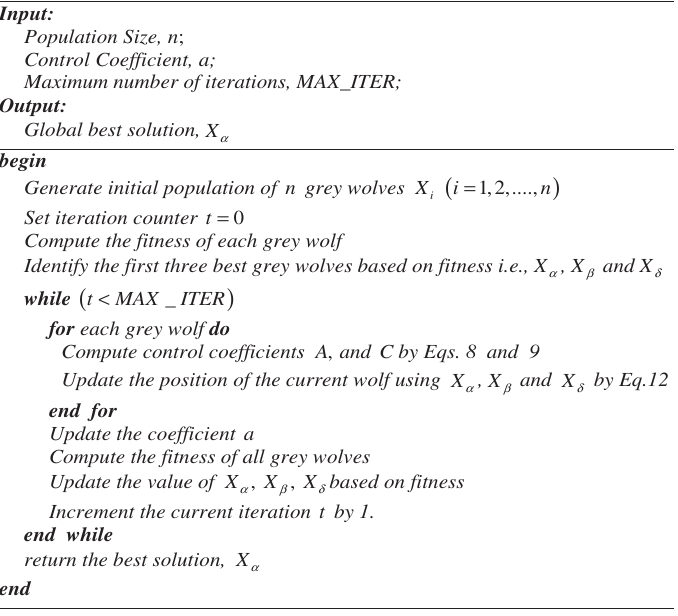
Figure 1: Pseudo Code of the